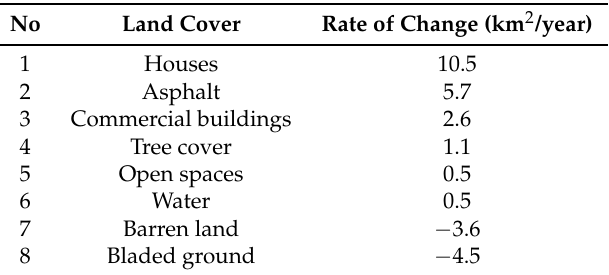
Table 2. Rate of change of land cover classes from 1990 to